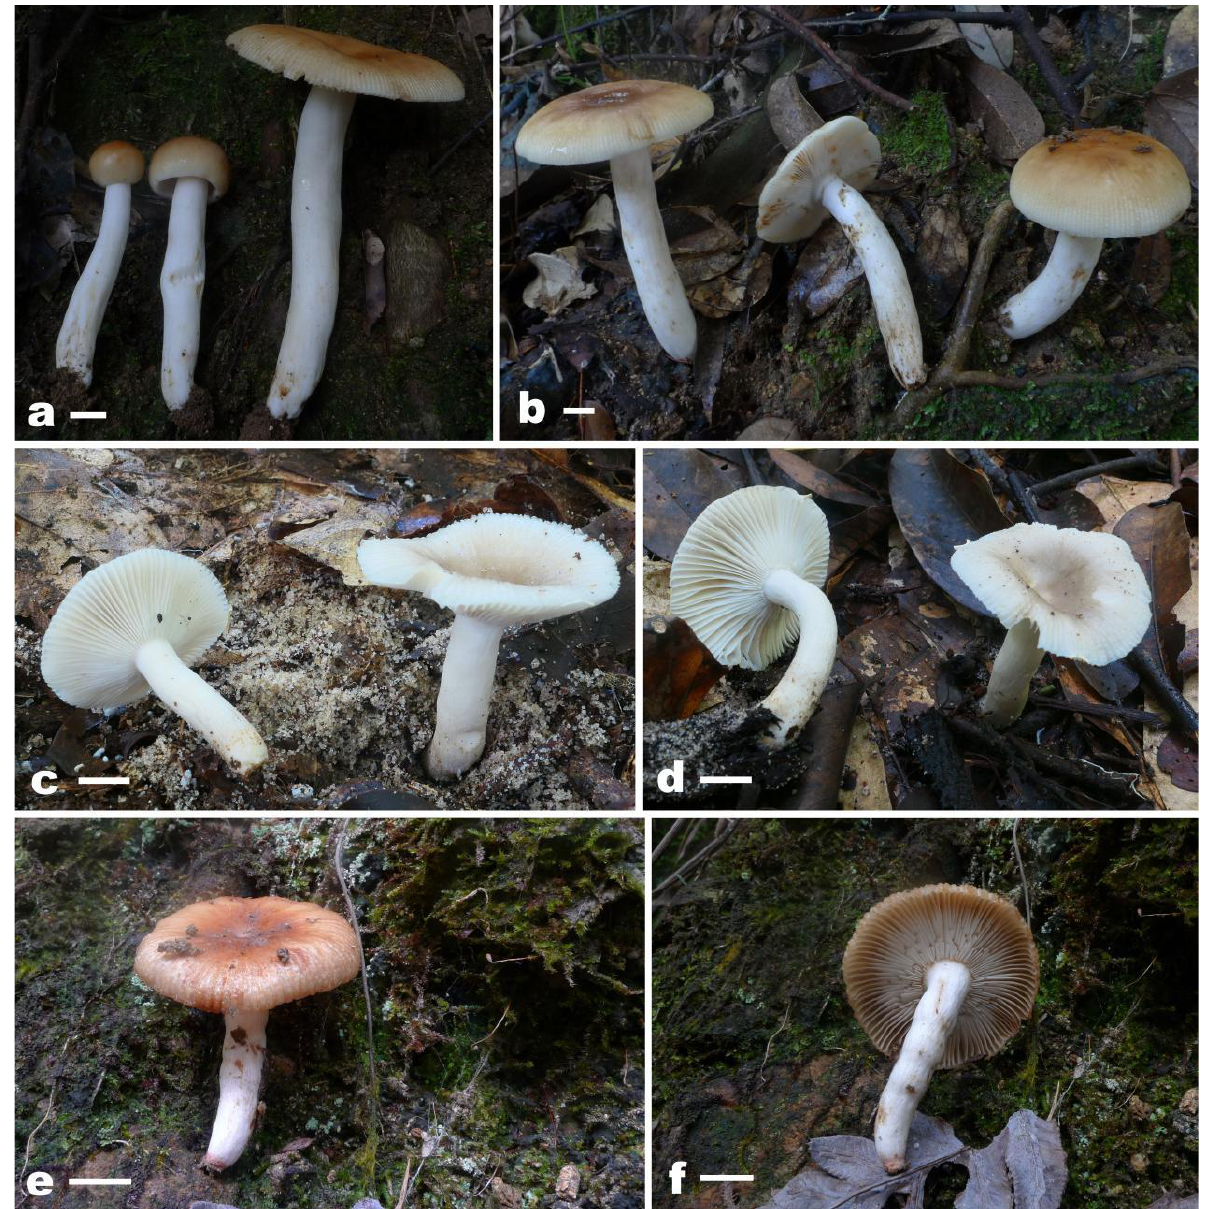
Figure 2. Basidiomata of Russula sect. Ingratae species. ( a , b ) R. fujianensis ( a ) from FHMU975, holotype; ( b ) from FHMU993); ( c , d ) R. oraria ( c ) from FHMU5355, holotype; ( d ) from FHMU5374); ( e , f ) R. rufobasalis (FHMU961). Bars: 1 cm. Photos: N.K. Zeng.